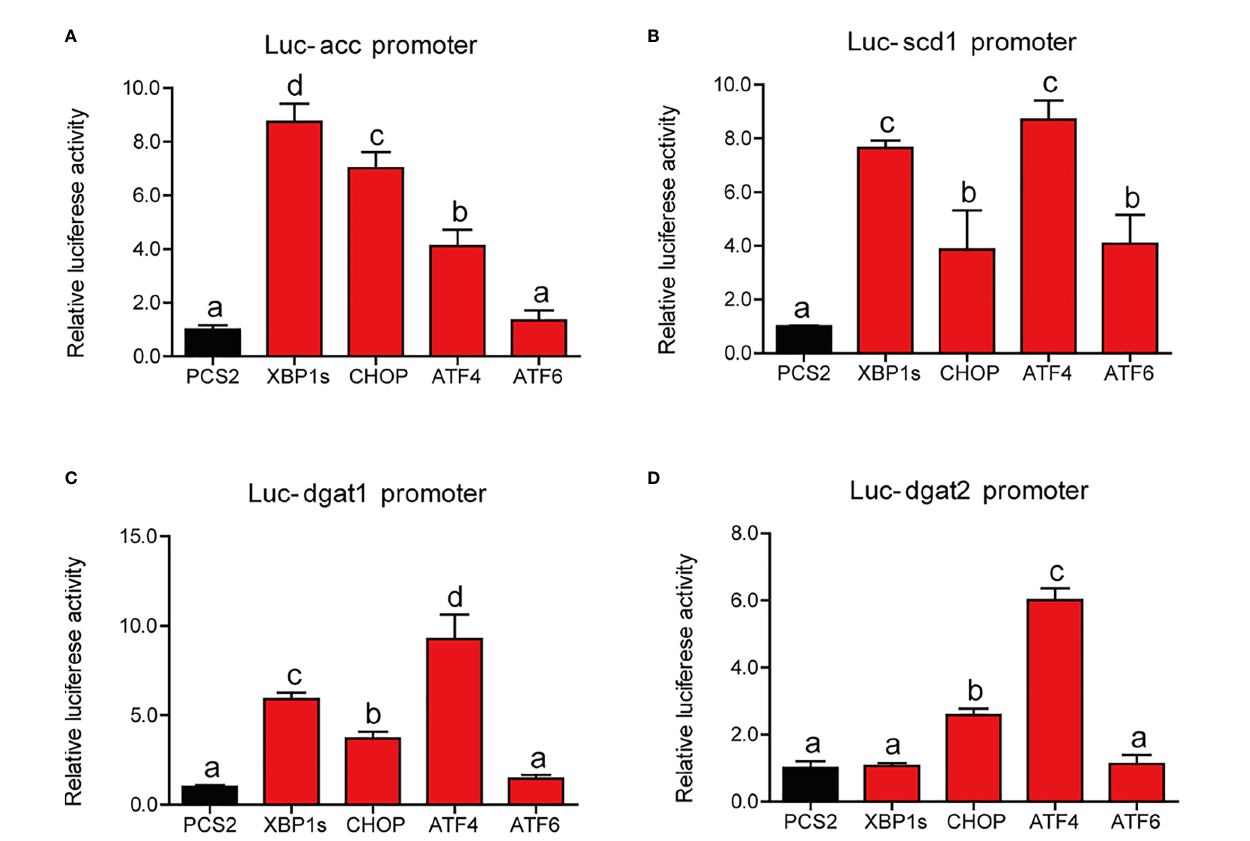
FIGURE 6 | Relative dual-luciferase activity analysis of UPR sensors in promoters of lipid synthesis-related gene in HEK293T cells. The promoter activities of acc (A) , scd1 (B) , dgat1 (C) , and dgat2 (D) were measured (n = 4). acc , acetyl-CoA carboxylase; scd1 , stearoyl-CoA desaturase 1; dgat1 , diacylglycerol acyltransferase 1; dgat2 , diacylglycerol acyltransferase 2. Results were analyzed using Tukey ’ s test [values without the same letter indicate signi fi cant difference ( P < 0.05)], and they were expressed as mean ± standard